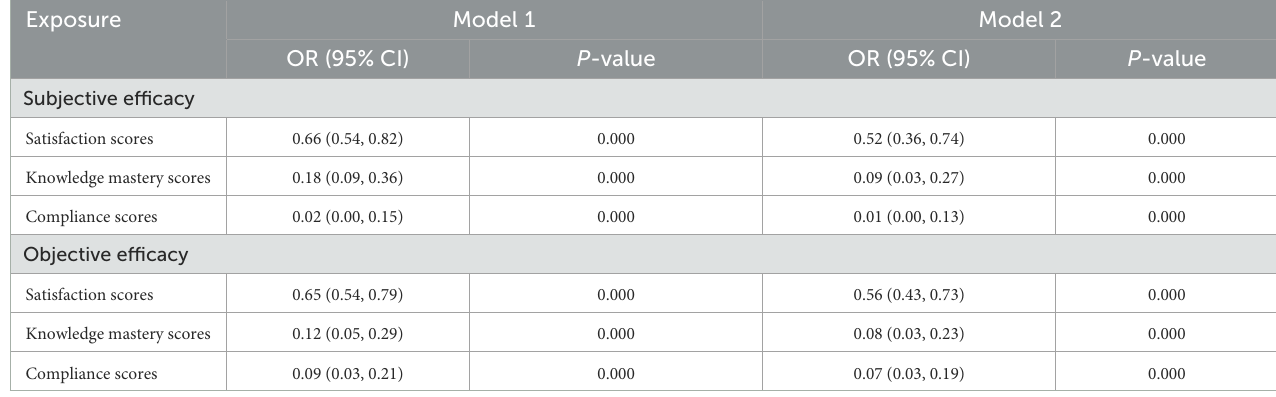
TABLE 3 Comparison of multifactor regression equations of subjective efficacy and objective